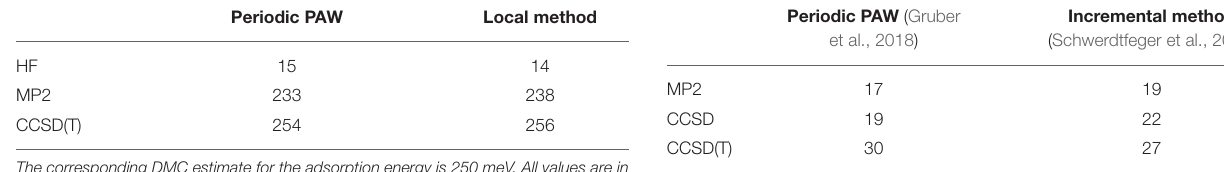
TABLE 3 | Calculated cohesive energy of the neon crystal as obtained using different theories and techniques. Periodic PAW (Gruber et al.,